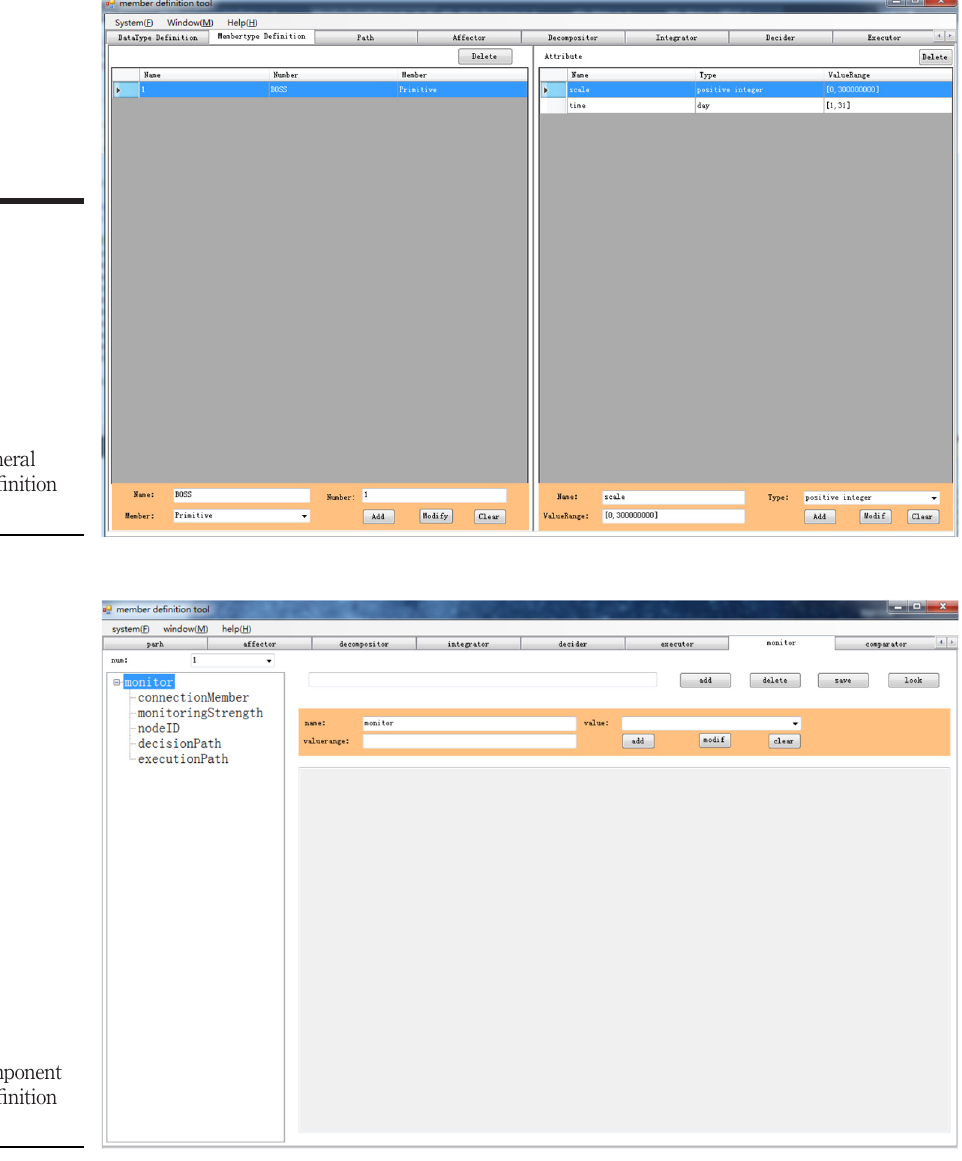
Figure 6. Speci fi c component attribute de fi nition